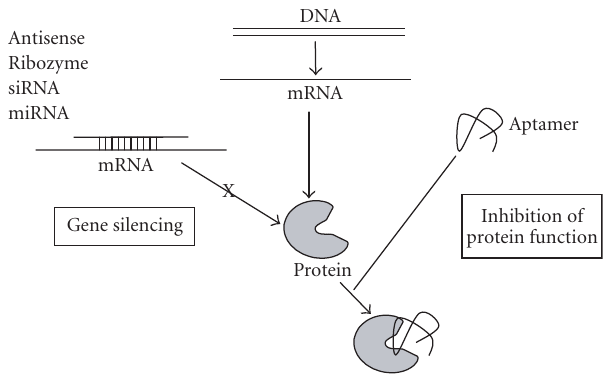
Figure 1: Schematic representation of the mode of action of ap- tamers compared to other ncRNAs. Antisense, ribozymes, siRNAs, miRNAs recognise the target nucleic acid by complementary base pairing and, by activating an intracellular molecular machinery, im- pair the expression of the corresponding protein. Aptamers act by directly binding the target without interfering with its